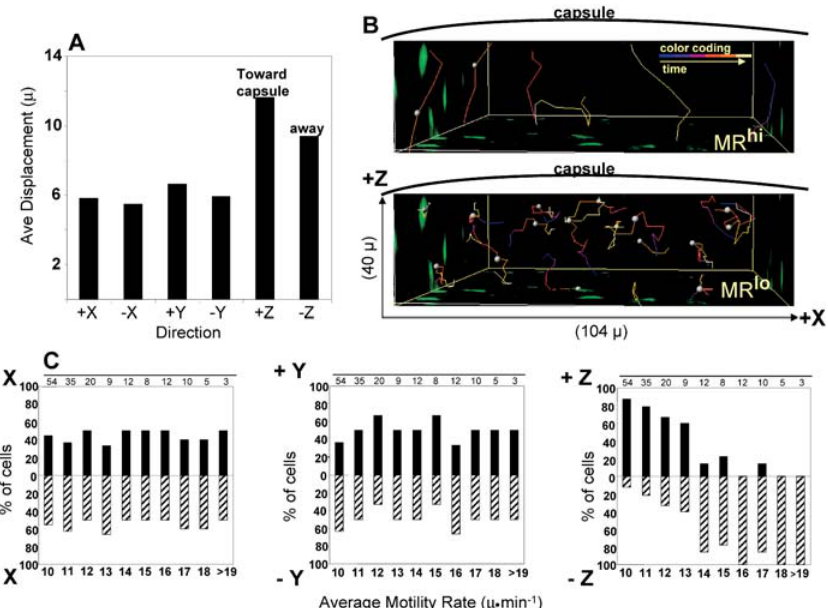
Figure 3. MR hi Thymocytes Show Preferential Movement Perpendicular to the Thymic Capsule (A) Bar graph showing the average displacement in each direction by wild-type MR hi cells in a 3-min interval. Data shown were computed from 53 MR hi cells from four independently imaged thymic lobes. Data from individual runs are shown in Figure S3. (B) The upper image is rotated to display the x and z dimensions showing tracks of MR hi cells. Five of six MR hi tracks show preferential orientation in the z direction. The lower image shows tracks of MR lo cells from same dataset. (C) The results of step analysis (see Materials and Methods) on 172 MR hi cells. Thymocytes are grouped according to their average motility rate (displayed on x -axis) and percentage of cells moving in either the positive or negative direction is displayed on the y -axis. Data are compiled from four independently imaged thymic lobes. DOI: